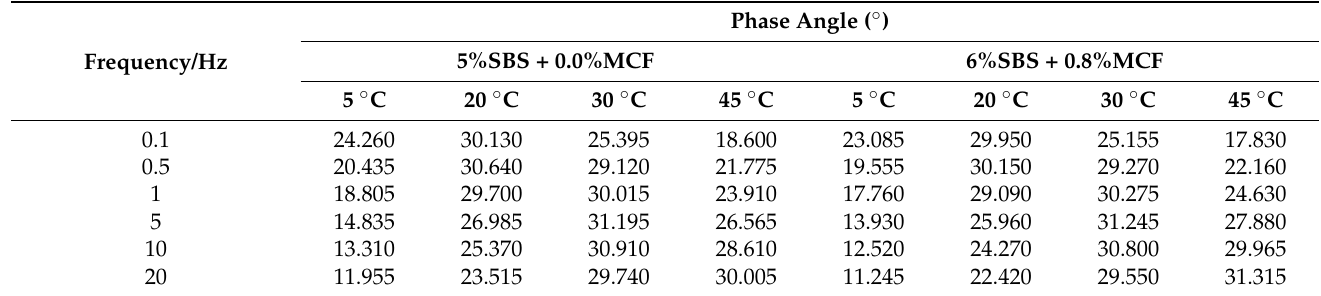
Table 11. Results of phase angle for modified asphalt